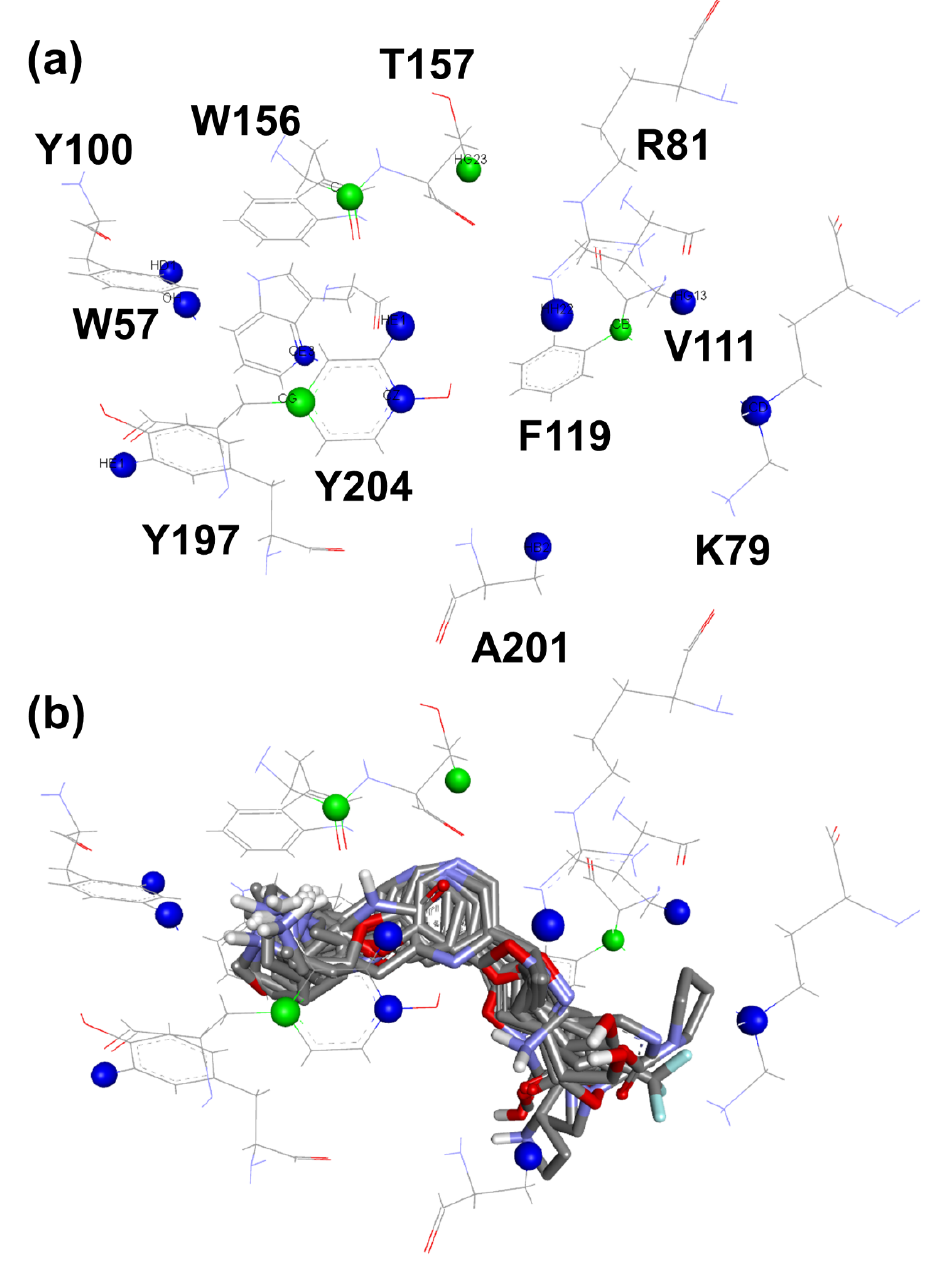
Figure 2. ( a ) Critical contacts from ( α 4) 2 ( β 2) 3 receptor dbCICA analysis and ( b ) best well-behaved ligands from dbCICA analysis overlay. ( a ) Positive contacts from ( α 4) 2 ( β 2) 3 receptor dbCICA model are shown in green and negative contacts are shown in blue. ( b ) Superposition of the best well-behaved ligands from dbCICA analysis (see ligands 1 , 3 , 4 , 5 , 6 , 7 , 8 , 9 , 10 , 11 , 12 , 13 , 14 , 15, and 16 , in Figure 4). Carbon atoms are shown in gray, nitrogen atoms in blue, oxygen atoms in red, fluorine atoms in light blue and hydrogen atoms in white. The Discovery Studio Visualizer software automatically named the atoms, and the residue numbering respects the originally published numbering from the PDB structure. Only polar hydrogens from ligands are